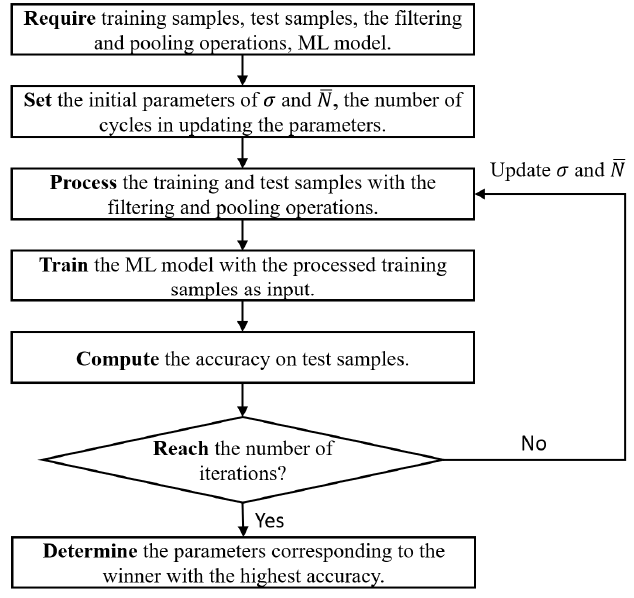
Figure 6. Optimizing